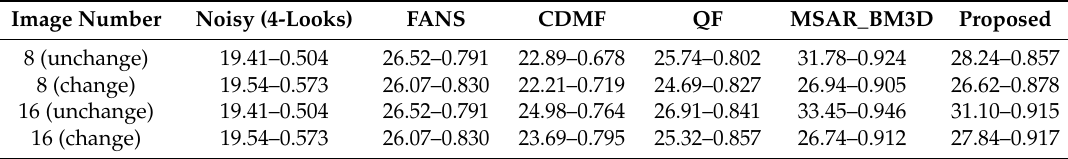
Table 2. The quantitative results of different methods on synthetic SAR images (PSNR-SSIM). Image